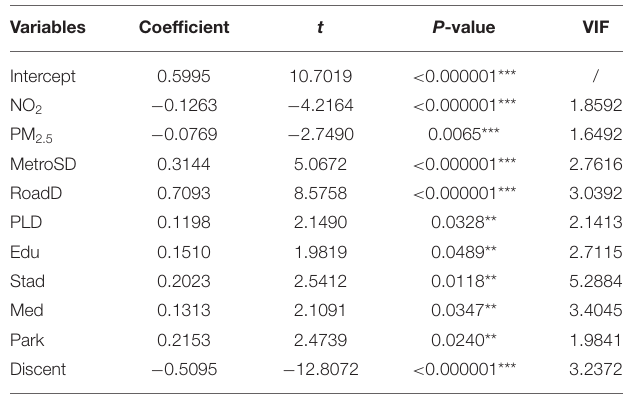
TABLE 3 | OLS regression results.